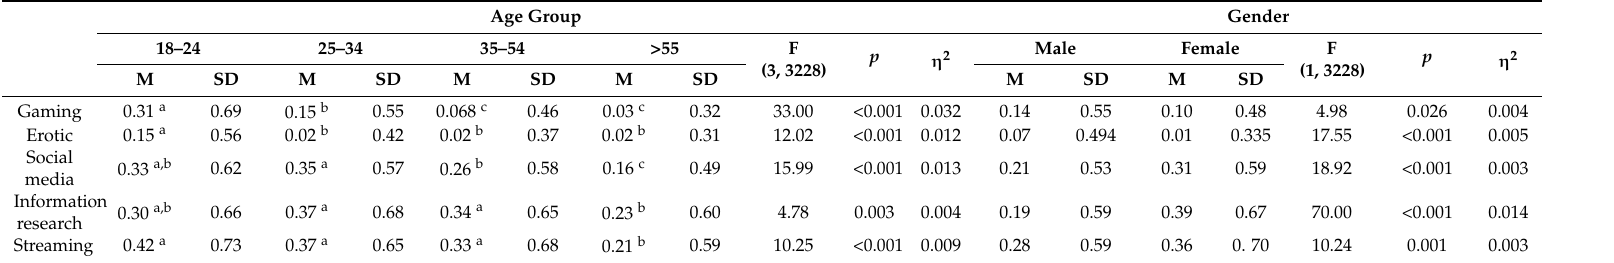
Table 4. Main effects of age groups and gender on changes in pre–post online media